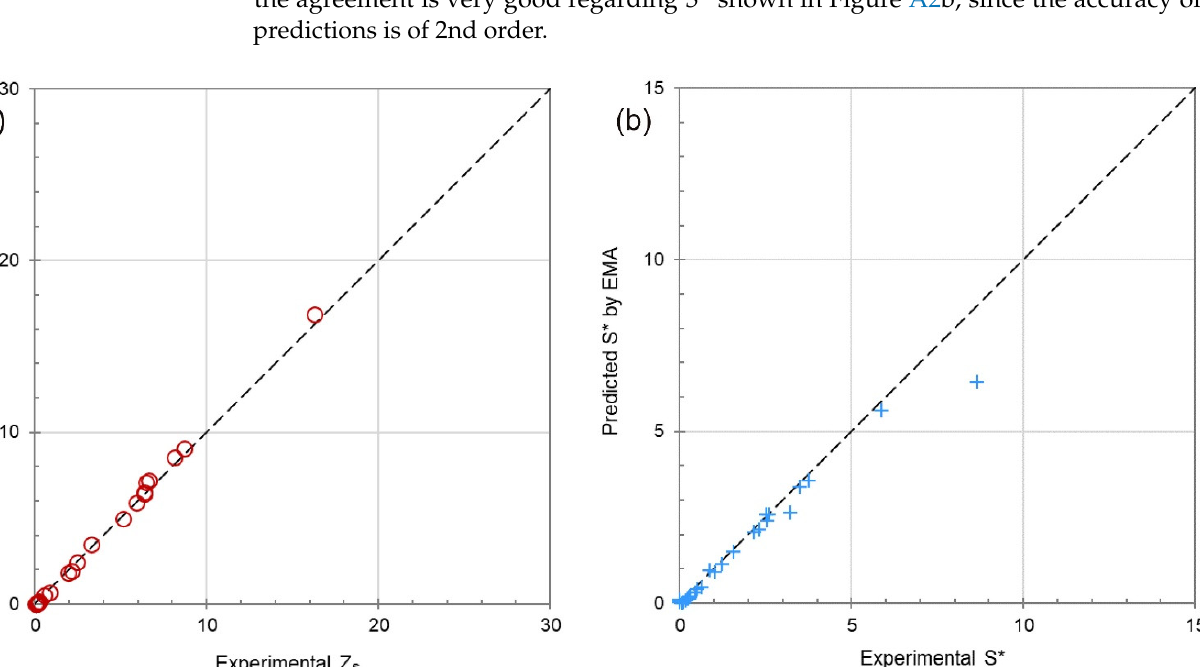
of the spreading layer; and 0 0